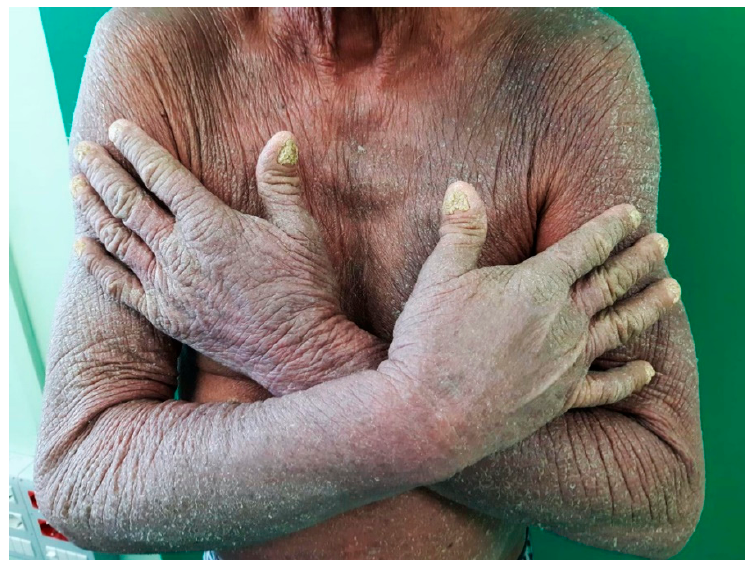
Figure 1. Clinical image showing a diffuse erythrodermic picture of psoriasis.